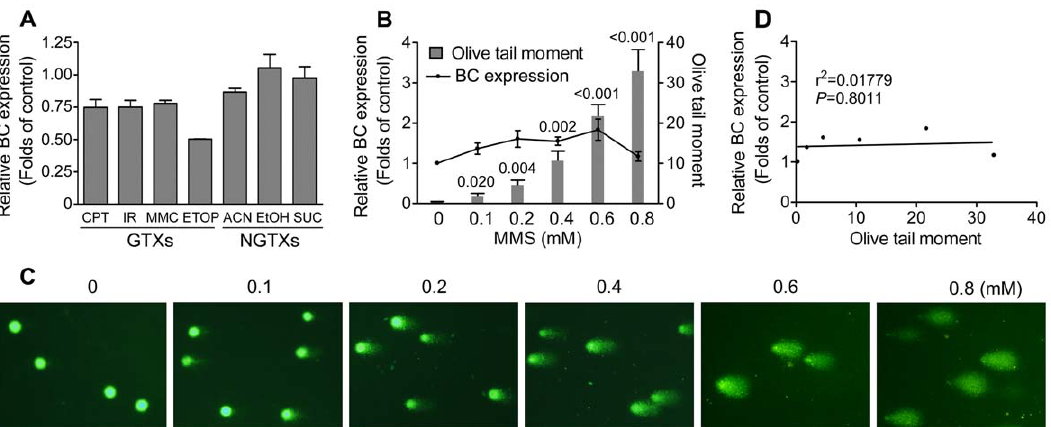
Figure 5. Expression of BC could not be induced by GTXs and did not correlate with DNA damage in L5178Y cells. ( A ) Quantitative PCR data showing transcriptional expression of BC in L5178Y cells treated with indicated chemicals for 4 h. Data were mean 6 s.d. of three independent experiments. ( B and C ) Comparison between expression level of BC and DNA damage in L5178Y cells exposed to MMS for 8 h. DNA damage was measured by olive tail moment (tail length 6 percentage of DNA in tail) in an alkaline comet assay (representative figures are shown in C). Data were mean 6 s.d. of three independent experiments. ( D ) Linear regression analysis between expression level of BC and DNA damage, reflected by olive tail moment. Each dot represents the mean of data shown in (B). Values shown on top of bars are P values vs control.